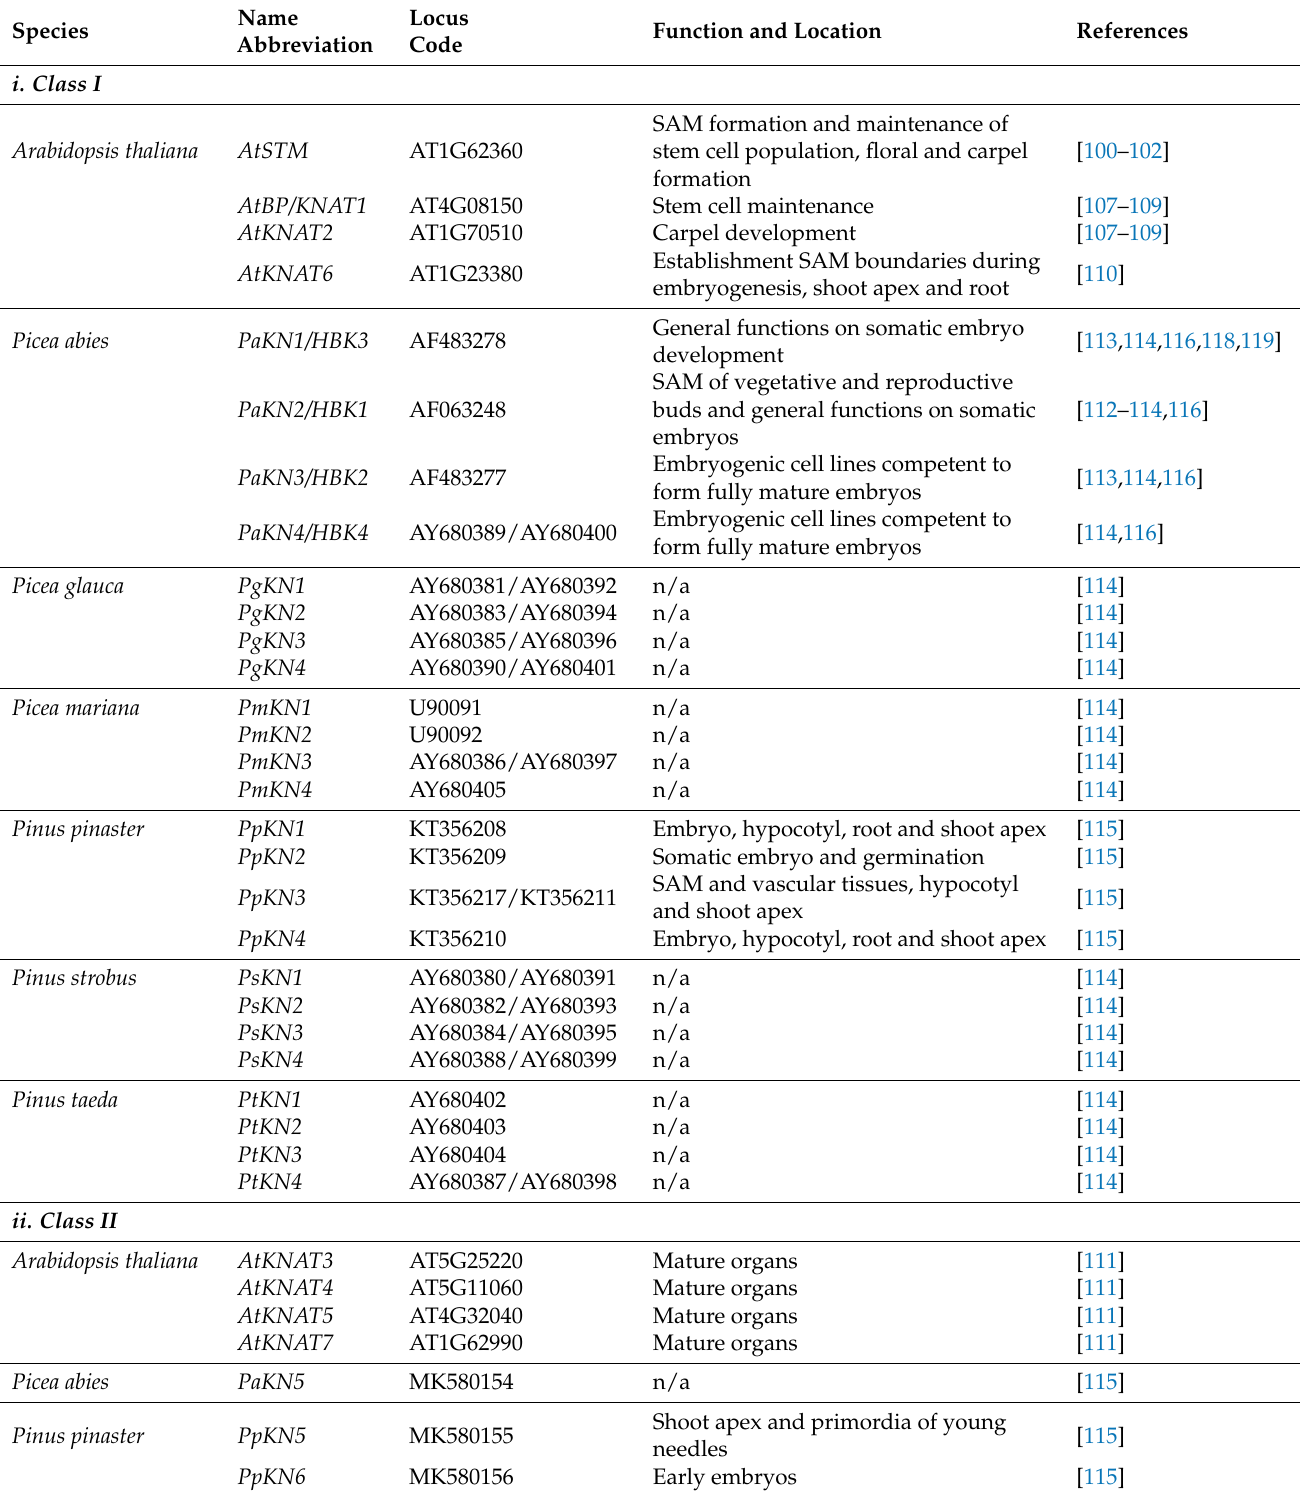
Table 2. List of genes belonging to the KNOTTED1-LIKE HOMEOBOX (KNOX) family, including those from model species Arabidopsis thaliana and their homologue genes already identified in gymnosperms, with name abbreviation, locus code (AGI code in case of Arabidopsis thaliana , GenBank number in case of gymnosperm species), function, location and references. Shoot apical meristem,